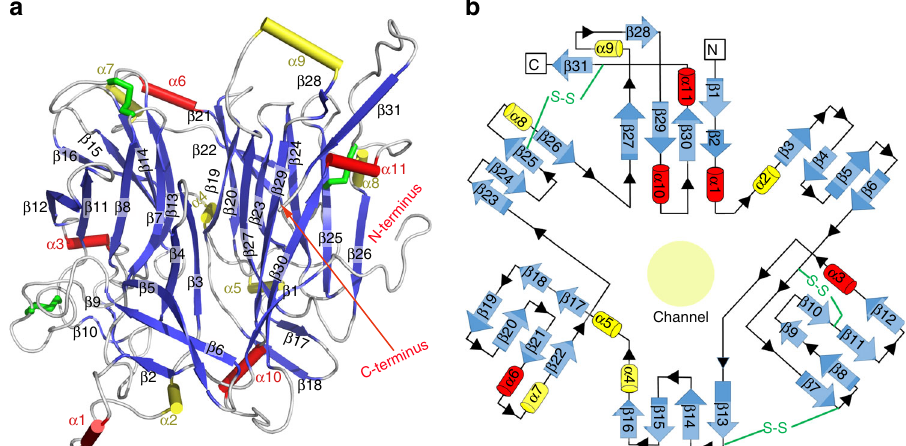
Fig. 2 Structural characterisation of the MRJP1 protomer. Secondary structures ( a ) and topology ( b ) of MRJP1 showing a six-bladed β -propeller fold. Three disul fi de bonds and the central channel are